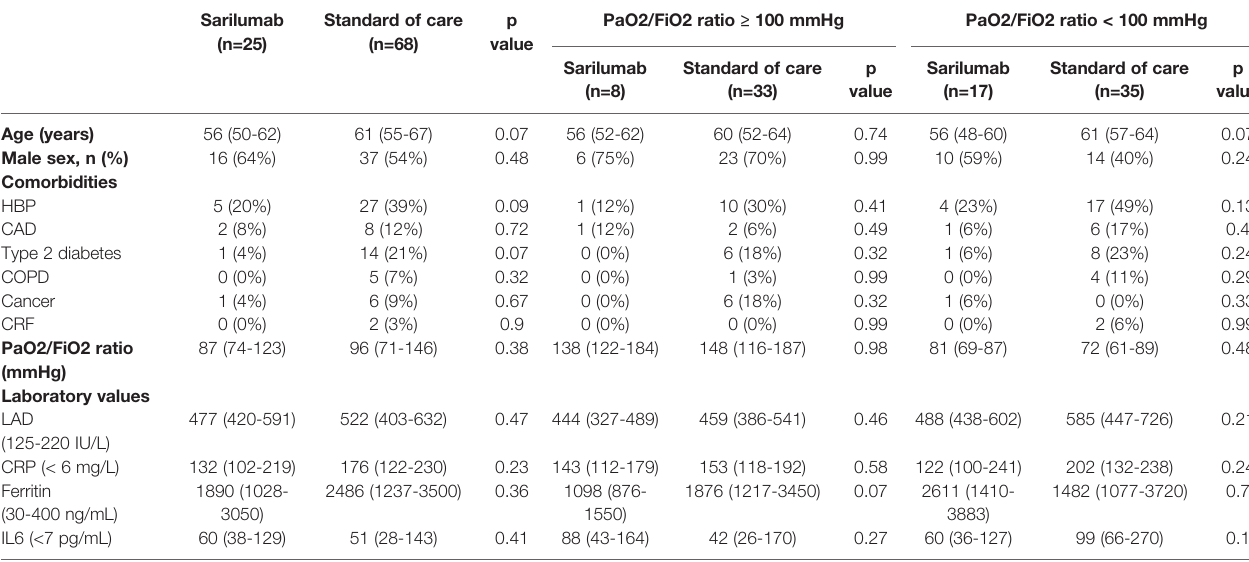
TABLE 3 | Clinical and serological features of patients treated with sarilumab.